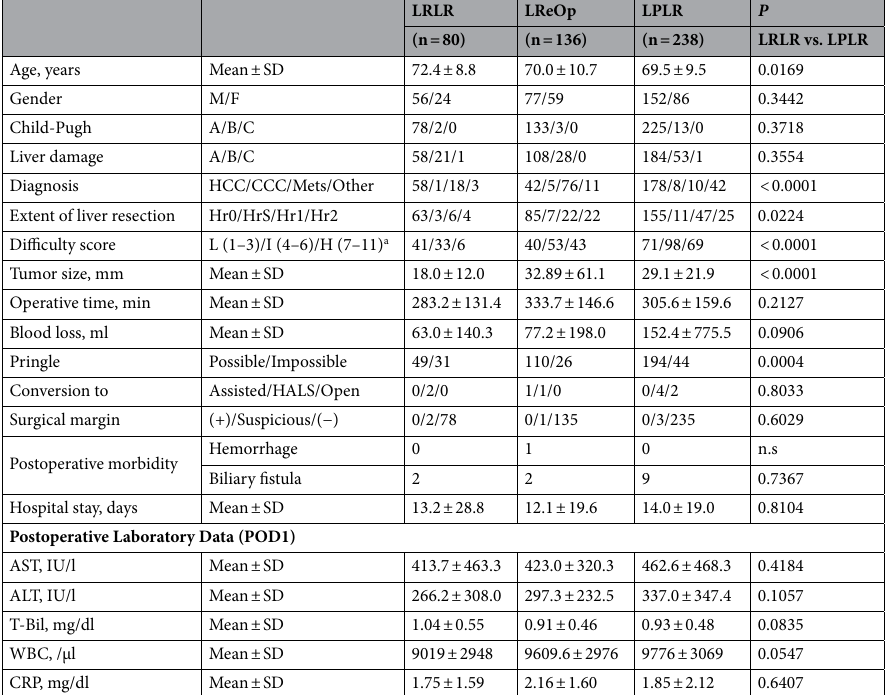
Table 1. Patient characteristics and surgical results of laparoscopic liver resection. HCC hepatocellular carcinoma, CCC cholangiocellular carcinoma, Mets metastasis, HALS hand-assisted laparoscopic surgery, n.s. not significant. a L: low, I: intermediate, H: